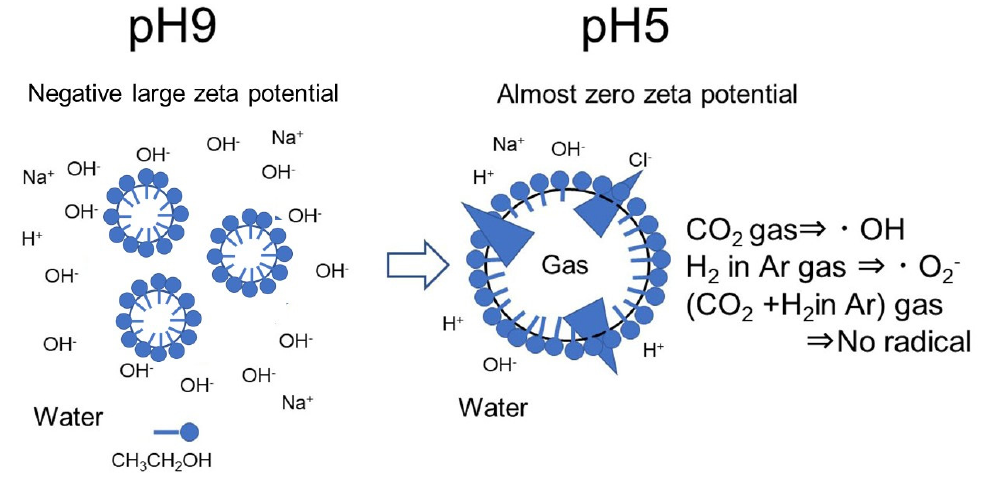
Figure 10. Model of nanobubble breakage by changing pH from 9 to 5 and the production of radicals by decreasing the bubble zeta potential absolute value.